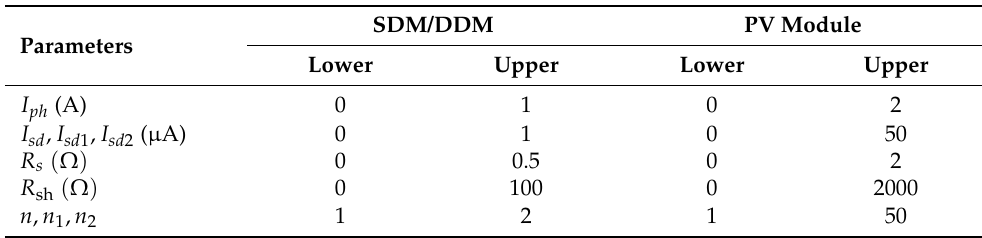
Table 2. Parameters of PV